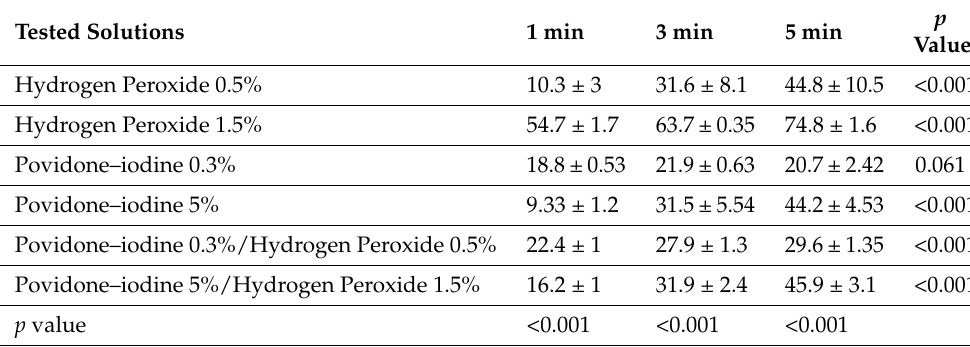
Table 2. Toxicity data in chondrocyte